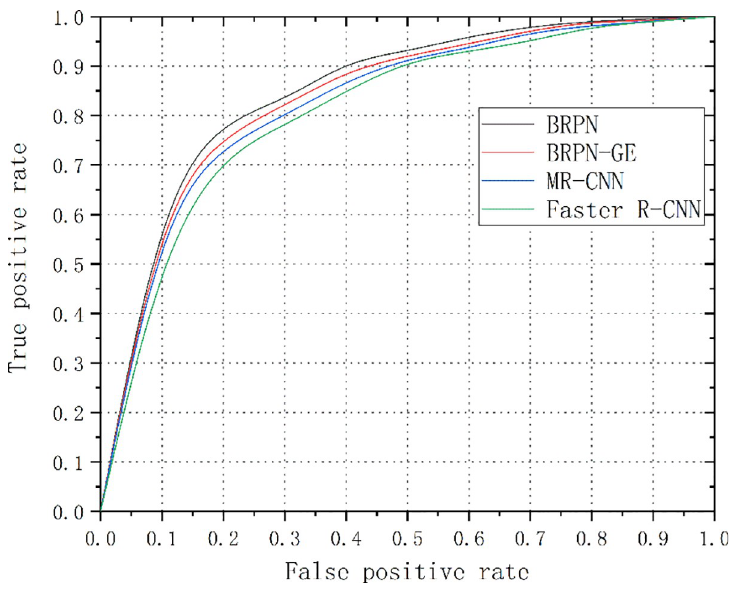
Fig 14. ROC curves of the compared methods.